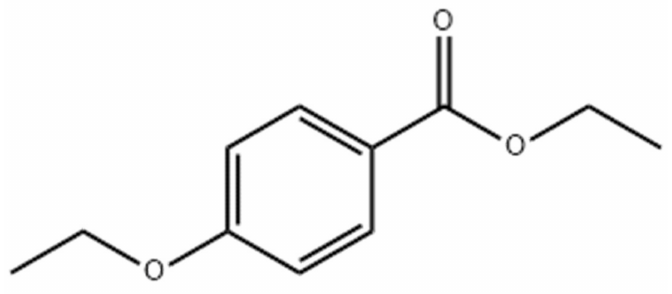
Figure 8. Chemical structure of ethyl 4-ethoxybenzoate (P6).